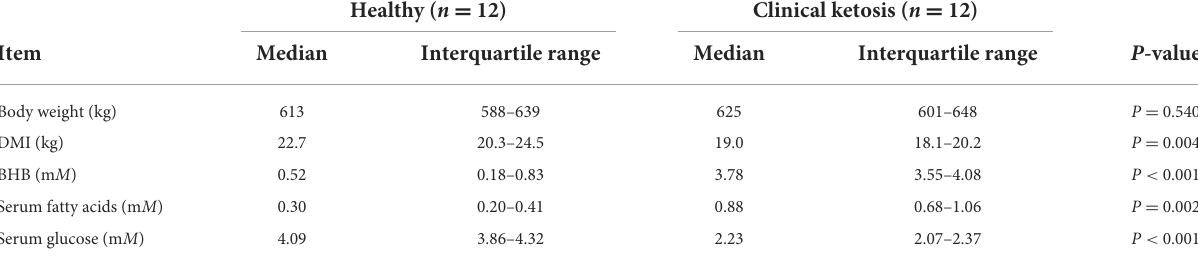
TABLE 1 Basic description of Holstein cows classified as healthy control ( n = 12) and clinical ketosis (CK, n = 12). Healthy ( n = 12) Clinical ketosis ( n =